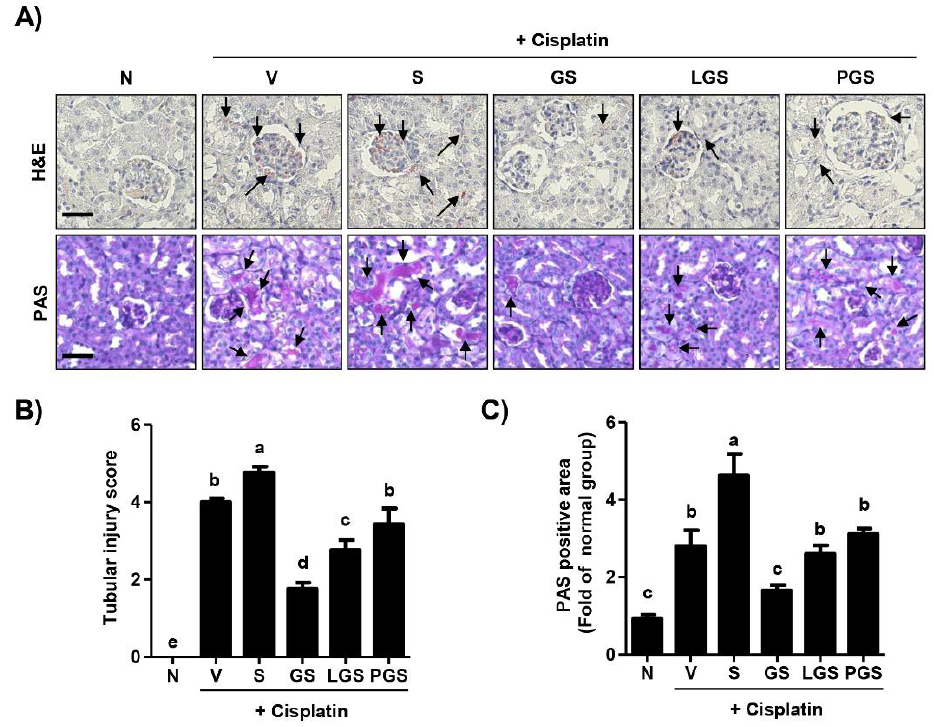
Figure 2. Effect of GABA on renal histological changes following a high salt intake in cisplatin-induced acute nephrotoxicity. ( A , top) Representative images of H&E-stained sections in the kidney. Black arrows indicate histological changes including mononuclear cell infiltration, tubular dilation, and hemorrhage. Scale bar = 100 µ m. ( A , bottom) Representative images of periodic acid Schiff (PAS)-stained sections in the kidney. Black arrows indicate glycogen accumulation in injury renal tubules that stained with a strong pink color. Scale bar = 100 µ m. ( B ) Tubular injury score evaluated on H&E-stained kidney sections. ( C ) Quantitative analysis for PAS-positive area. ( B , C ) Data are expressed as means ± SD ( n = 3). a–e Bars with different letters are significantly different at p < 0.05 by Tukey test. N, normal group; V, cisplatin + saline group; S, cisplatin+ 4% high salt group; GS, cisplatin + high salt containing GABA group; LGS, cisplatin + 4% sodium containing lacto GABA salt group; PGS, cisplatin + 4% sodium containing postbiotics GABA salt group.